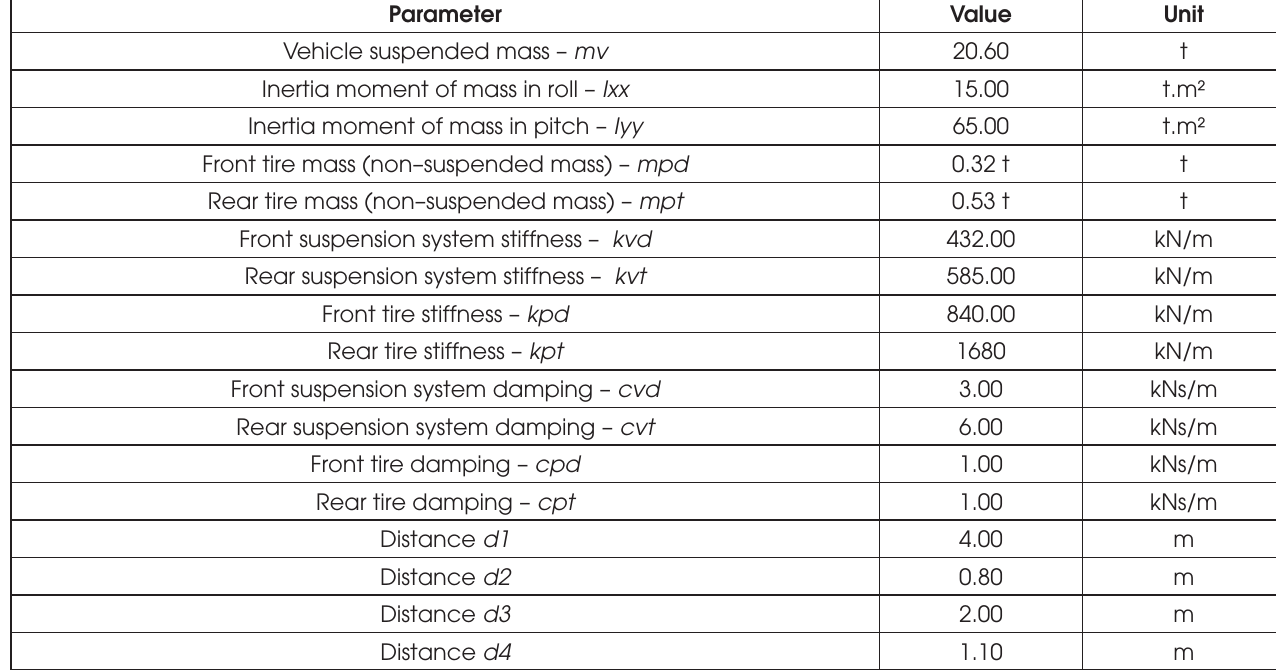
Car mechanical and dynamic